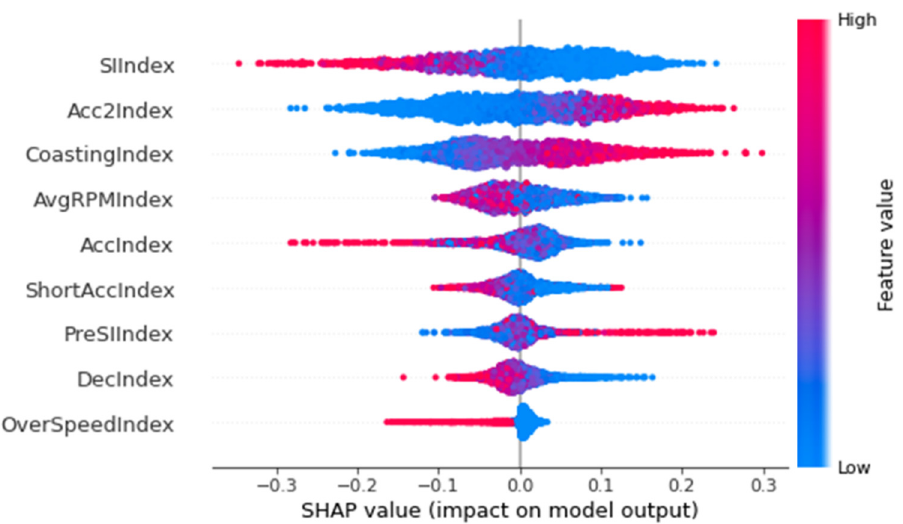
Figure 5. Tree explainer overview of fuel economy prediction model.